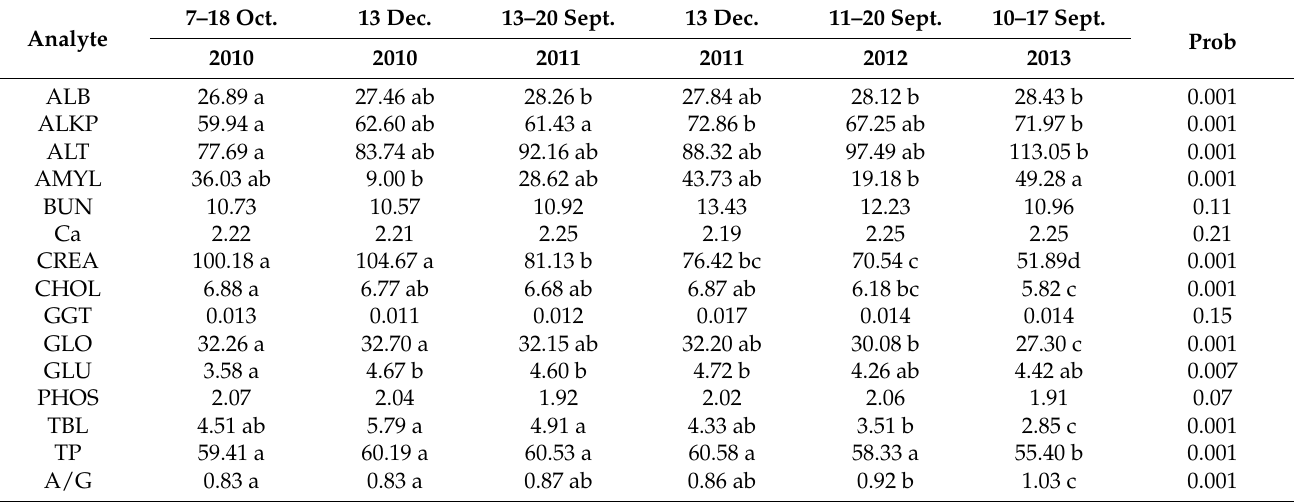
(Table 8). The probabilities and directions of changes in the original data for all analytes were similar to the estimates for the corresponding transformed data, except for AMYL, which was significant in the transformed data and was non-significant in the original data, although the directions of the changes over time were the same. Table 6. Back-transformed values of serum analytes for the inoculation dates and the probabilities of differences among groups § .